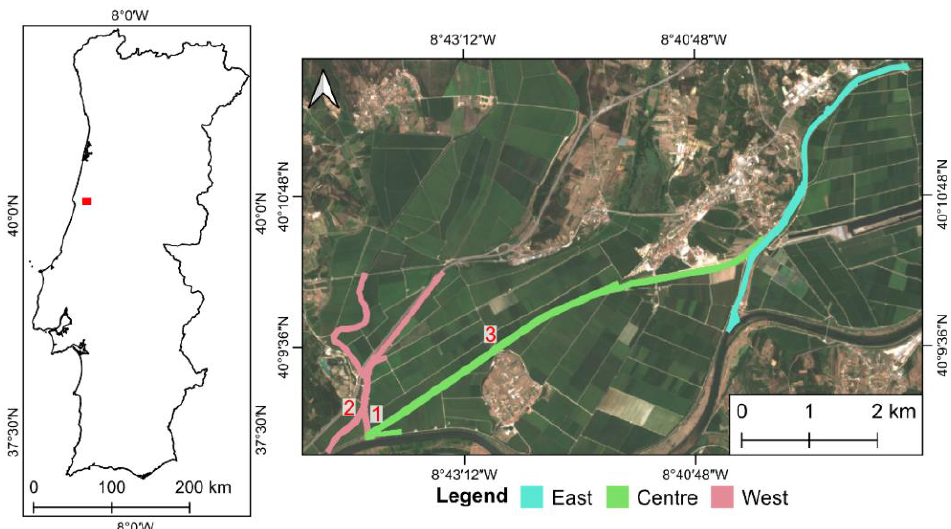
Figure 1. Study area overview: its location within mainland Portugal (red polygon), the extension of the analyzed water channels, and the three locations surveyed with the unmanned aerial vehicle.